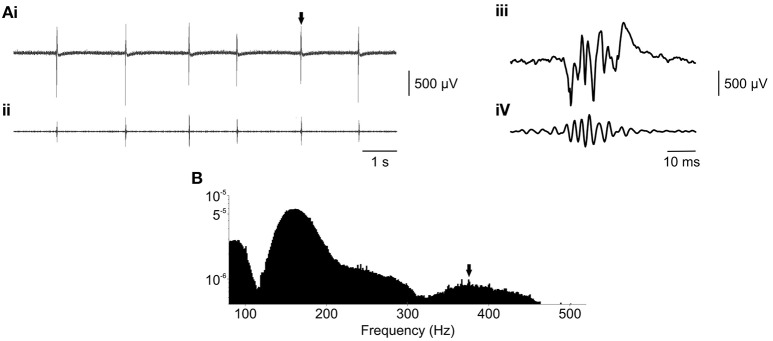
Fast ripples can be modeled in the membrane chamber using ex vivo slices. (Ai) Raw epileptiform fields recorded ex vivo, in a brain slice from a TeNT-treated rat, in the presence of 6 mM K+. (Aii) Raw data from (Ai), bandpass filtered between 300 and 500 Hz, revealed the presence of fast ripple oscillations. This was confirmed by examination of the waveforms on a shorter time base (Aiii, raw and Aiv, 300–500 Hz) and power spectral analysis (B), power calculated by fast Fourier transform, length = 4096, and plotted on a logarithmic scale) which revealed a separate peak in the fast ripple band, as indicated by the arrow.